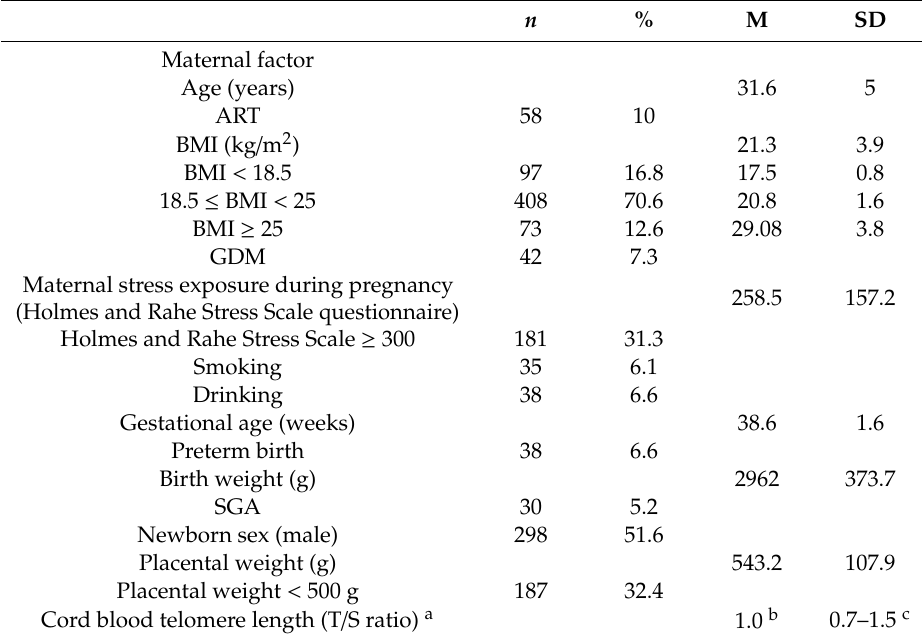
Table 1. Characteristics of the participants (N = 578).